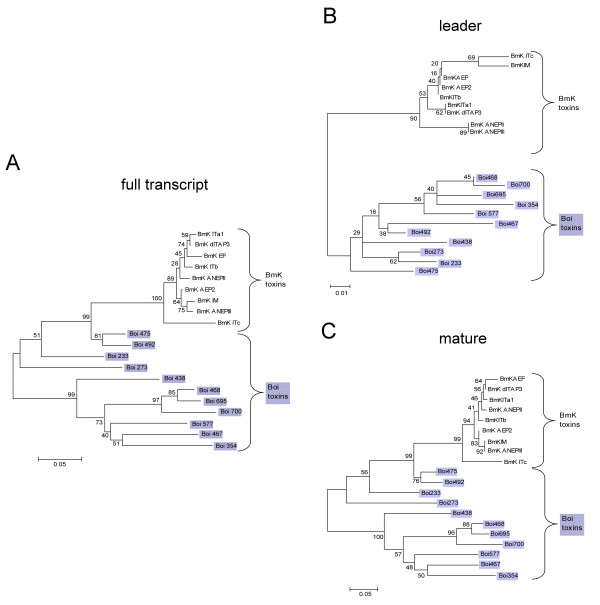
Phylogenetic trees of the depressant toxin family of Boi and BmK scorpions. (A) Full transcript, (B) leader-coding domain and (C) mature-coding domain of depressant toxins from both Boi and BmK scorpions were aligned by the MUSCLE algorithm and edited manually with Jalview. Trees were constructed by the neighbor-joining method, based on maximum likelihood composite. Numbers on the branches are bootstrap percentages, while brackets mark the genus origin of the toxins. Boi transcripts are shadowed in blue.